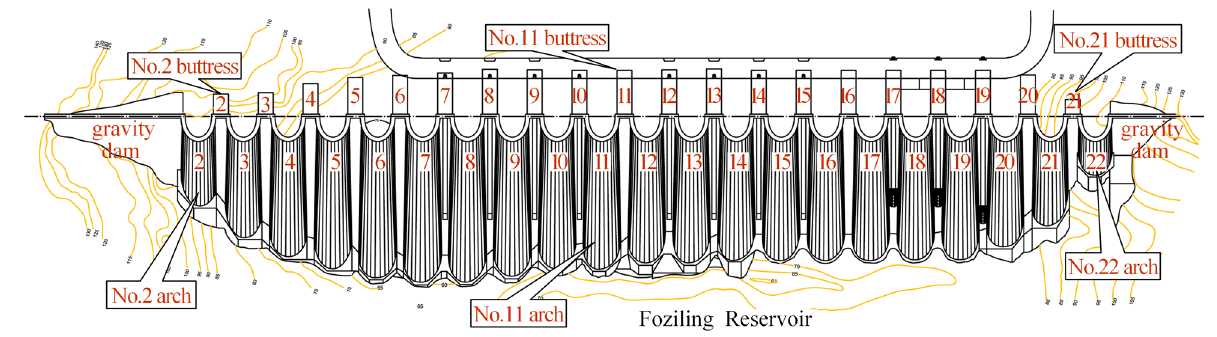
Figure 2. The layout of Foziling multi-arch dam.